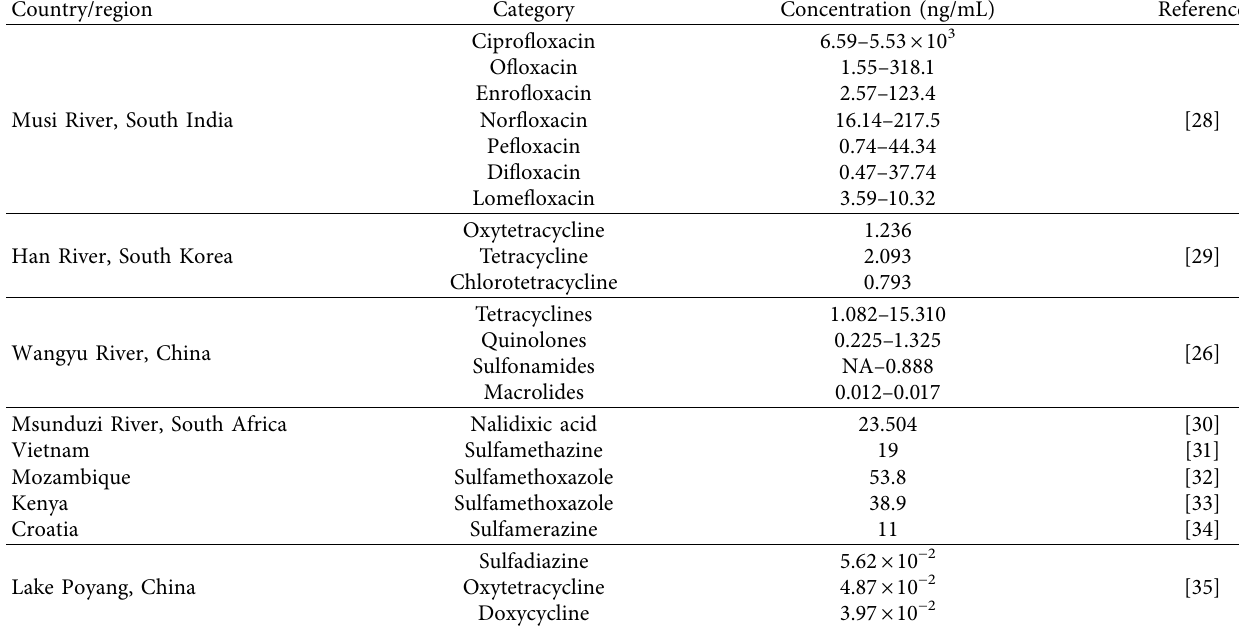
Table 1: Antibiotic concentrations in